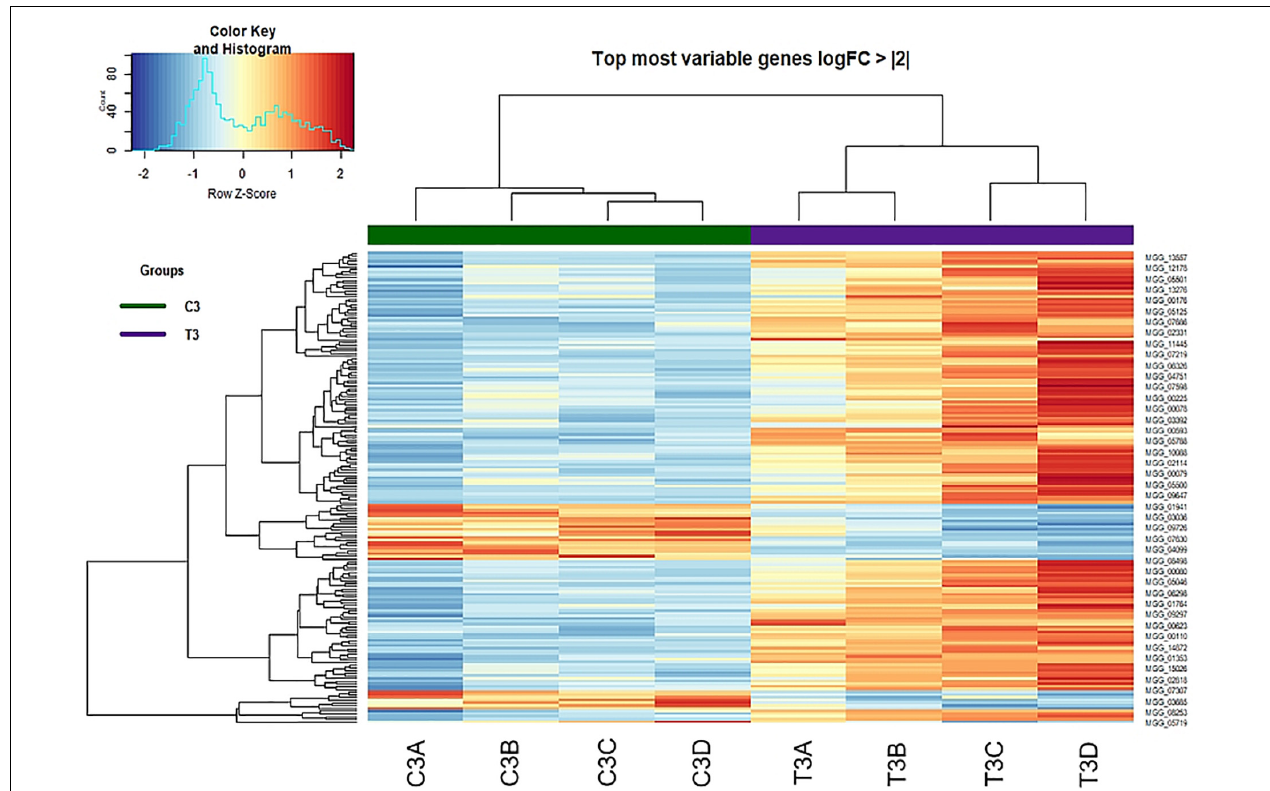
FIGURE 6 | Heat-map of DEGs with log Fold Change of at least + 2 or –2 identified at 3 h from treatment (Control vs.